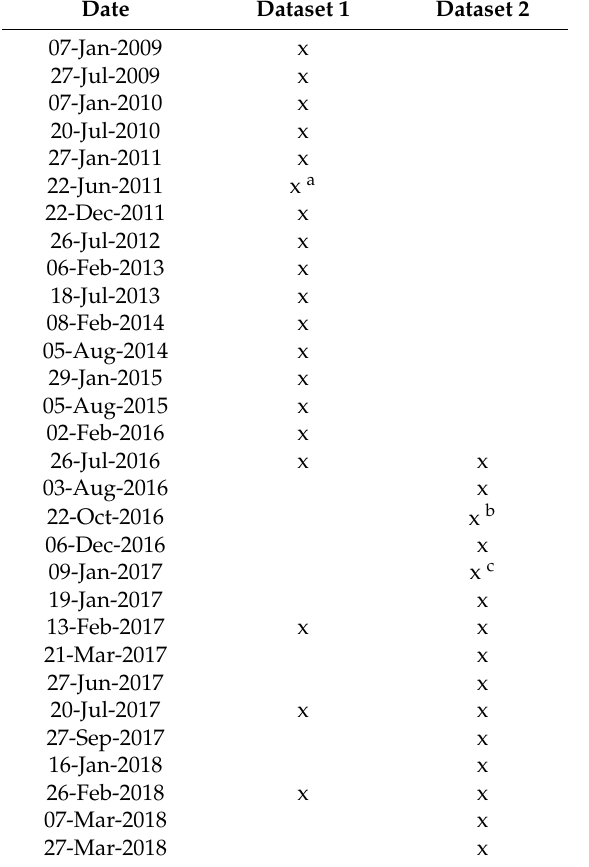
Table 1. Dates of topographic surveys included in dataset 1 and dataset